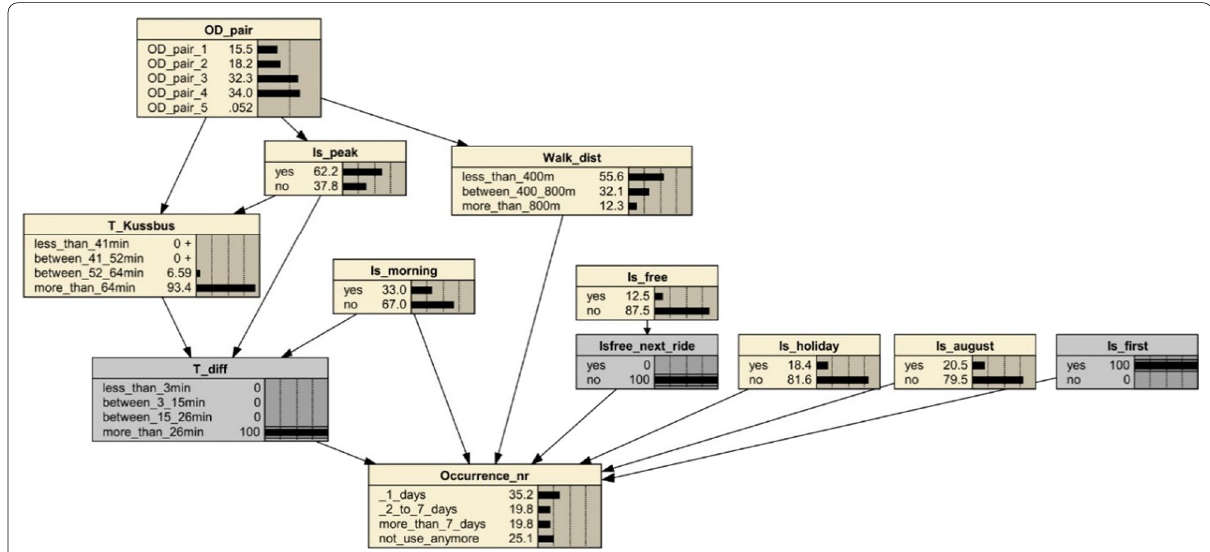
Fig. 7 Example of the probability changes in users’ next ride occurrence given new evidence from “T_diff”, “tIsfree_next_ride”, and